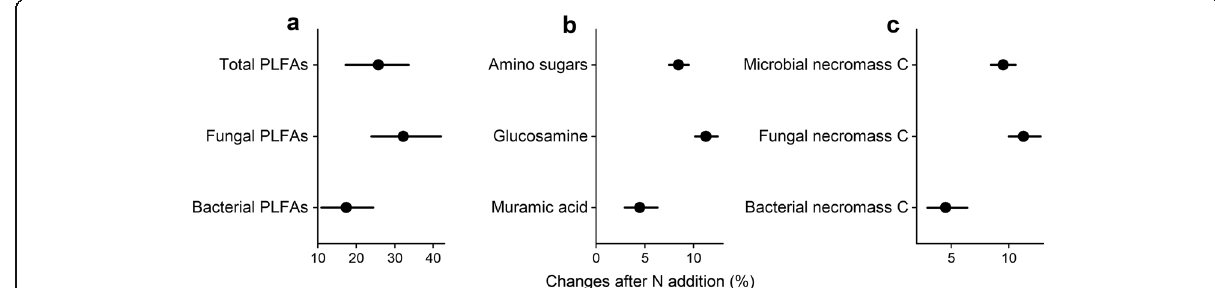
Fig. 2 Percent changes in a phospholipid fatty acids (PLFAs), b amino sugars, and c microbial necromass carbon (C) after nitrogen (N) addition. The upper values show the total PLFAs, amino sugars, and microbial necromass C, and the middle and lower values show the fungal and bacterial values separately. Glucosamine and muramic acid are biomarkers for fungal and bacterial necromass C, respectively. Error bars represent the 95% bootstrap confidence intervals that were calculated by weighted effect sizes. The responses of these variables to N addition are considered significant ( P < 0.05) if the 95% bootstrap confidence intervals do not overlap with zero. All these variables were collected at the control and N addition plots at the 11 sites at which microbial necromass C data were